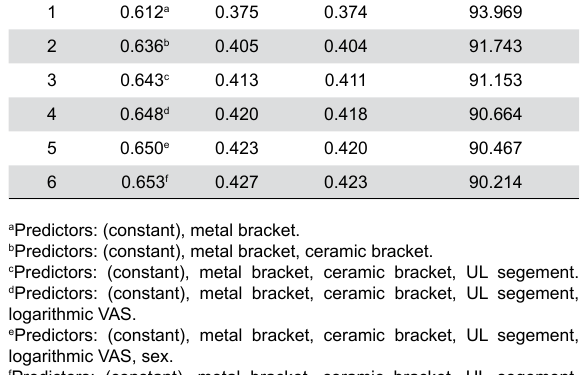
Table 5- Model Model